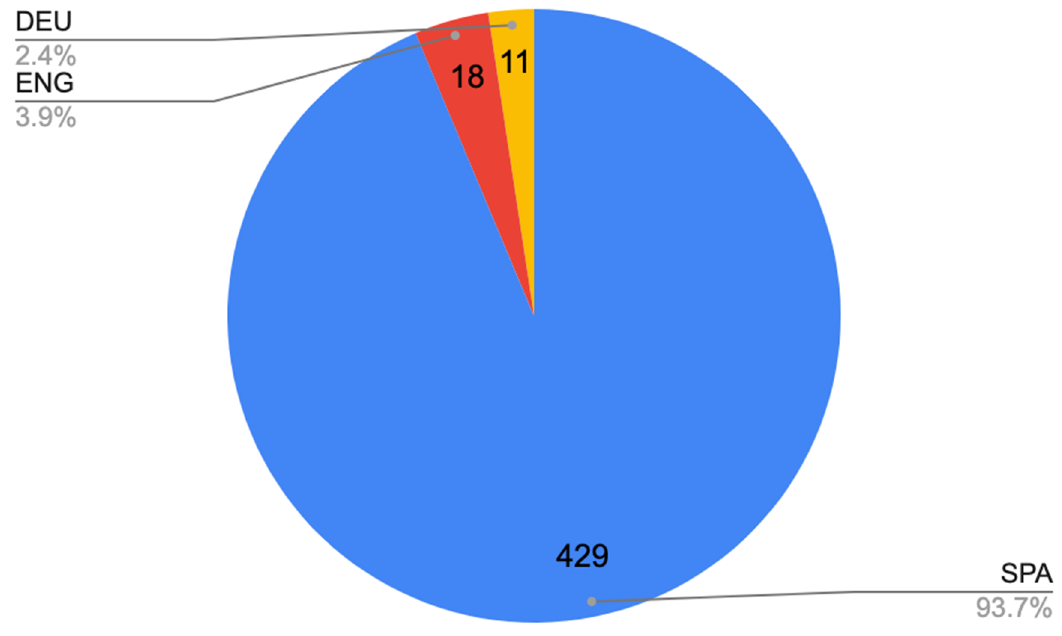
Figure 5. Tweets by language. Source: own elaboration.